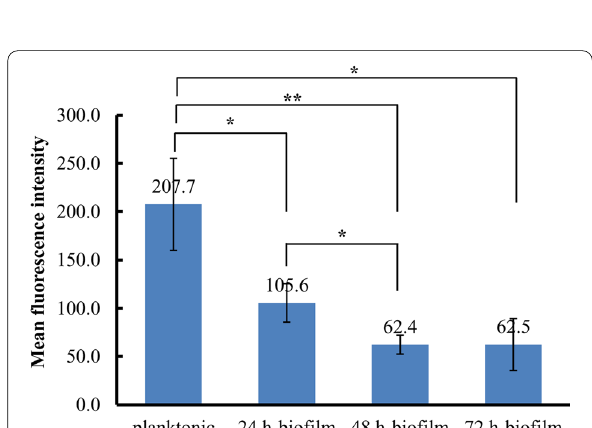
Fig. 6 The mean fluorescence intensity of intracellular NO in P. aeruginosa PAO1 at biofilms and planktonic states, respectively. Data were collected from three independent experiments with at least three replicates each and normalized to log 10 CFU. Error bars represent the standard deviation from three independent experiments. P values that are significantly different by T.test are indicated by asterisks as follows: *, P < 0.05; **, P < 0.01; ***, P <